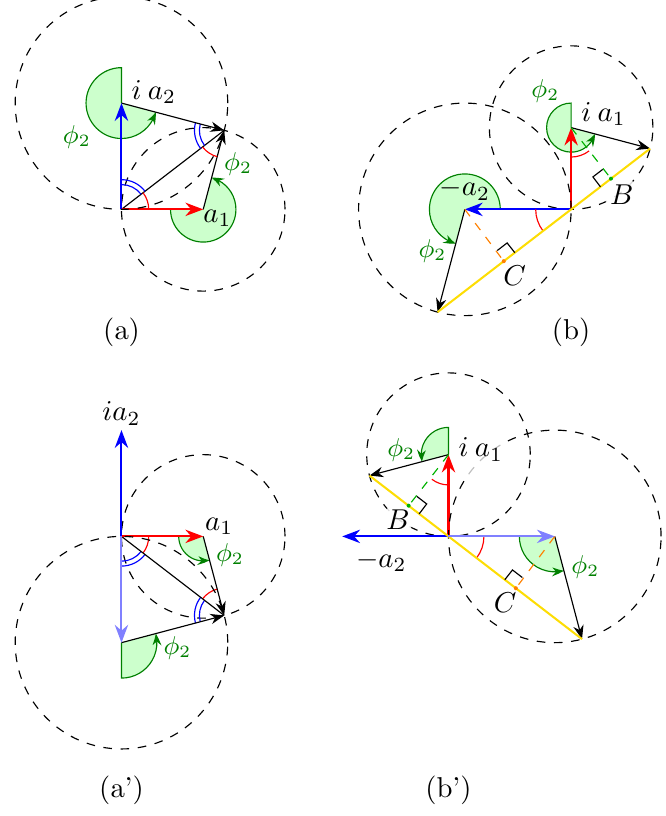
Figure 3. Phasor diagrams for the two components of A out , when both conditions of Equation (6) and (7) are fulfilled. ( a ) The four vectors form a quadrilateral. Note that Equation (7) can be deduced observing that the quadrilateral is the union of two congruent rectangle triangles with catheti a 1 and a 2 and thus the green angle equals twice arctan ( a 2 / a 1 ) (or the explementary angle, for a’, when n is odd). ( b ) When Equation (6) is fulfilled, then the segments joining the origin with the points on the circumferences lie on the same line. The construction in figure shows that, when Equation (7) holds too, the segment between those two points is twice the hypotenuse of the rectangle triangle with a 1 and a 2 as catheti, which corresponds to the norm (power) of the input vector. Notice that, if one of the two angles (but not both) is changed by π , then the role in (a) and (b) gets reversed, i.e., the whole power goes in the top